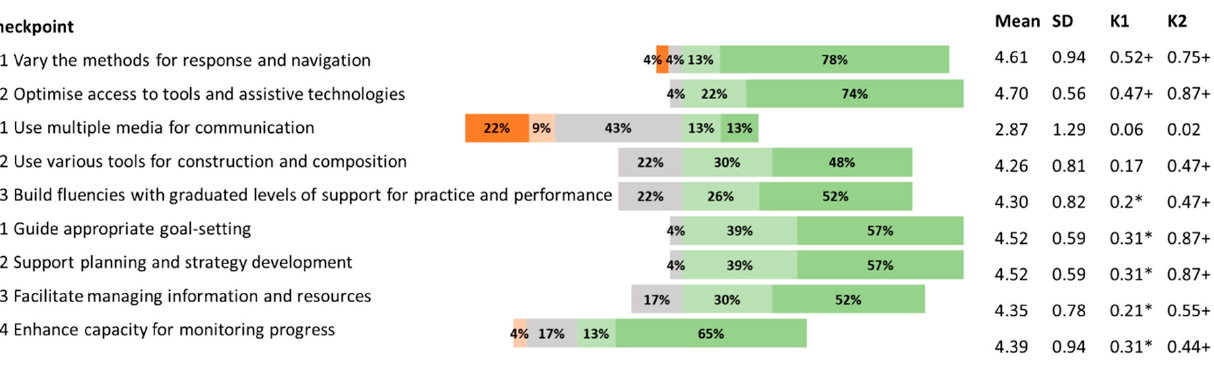
Figure 5. “Provide multiple means of action and expression” evaluation results. Note: standard deviation (SD), Kappa for 5 values (K1); Kappa for 3 values (K2); fair agreement *; moderate, substantial, and perfect agreements +.